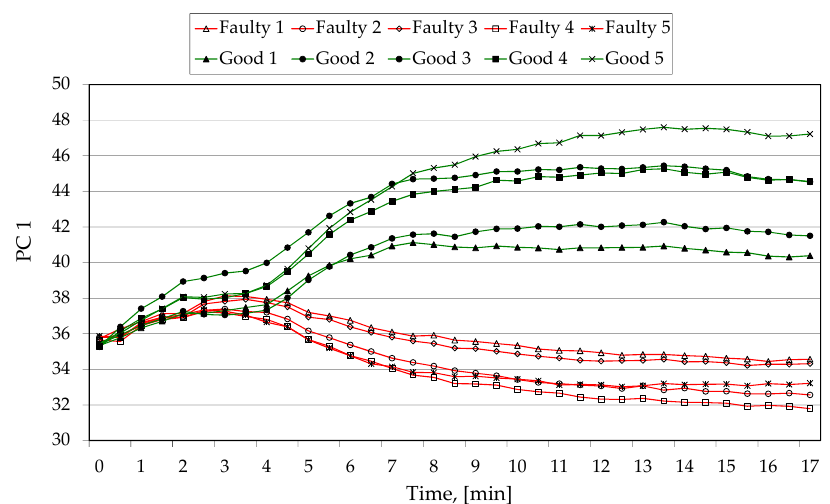
Figure 4. Time dependence of the first principal component (PC1) of thermal images (10 devices).